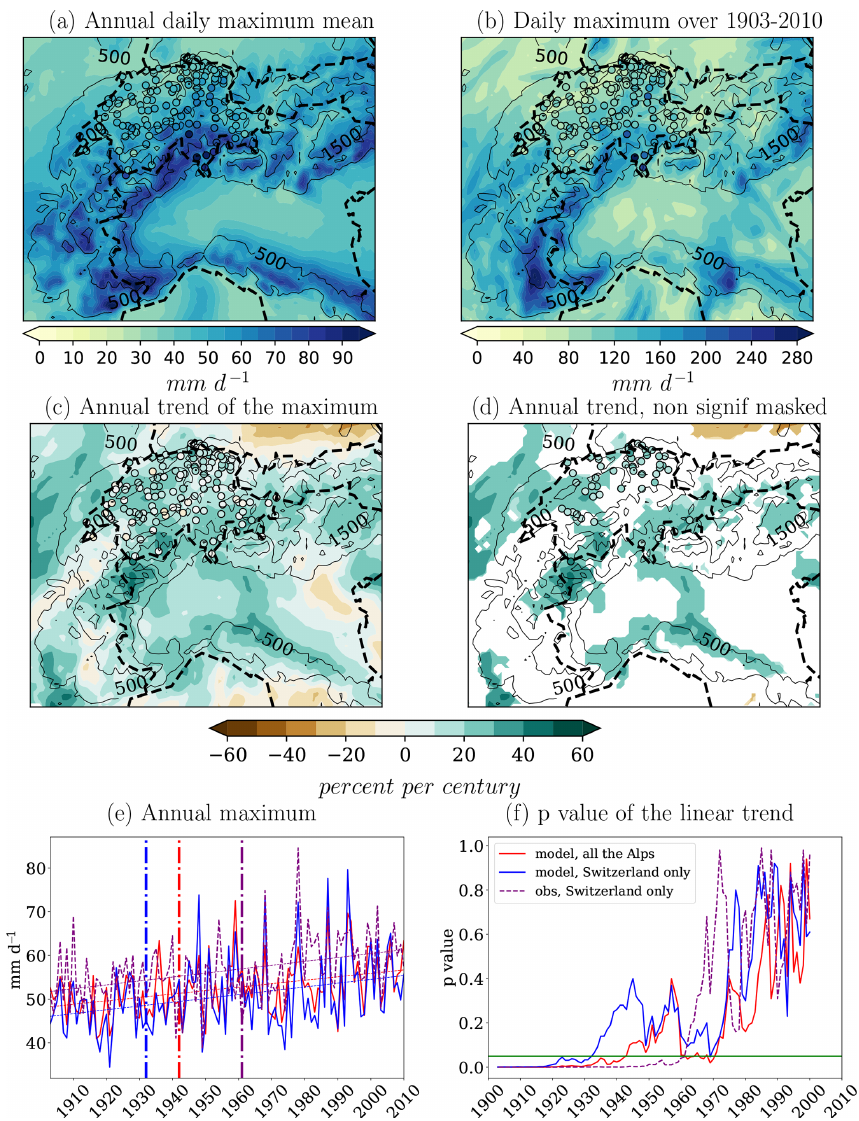
Figure 8. Mean (a) and maximum (b) of the annual Rx1day (mmd − 1 ) and its trend (% per century) including (c) and excluding (d) the areas where the p value is lower than 0.05, over 1903–2010. Annual Rx1day (e) and associated p value of the trend (f) over the same period averaged over the model domain (red for the entire Alpine region and blue for the Swiss domain only) and for the MeteoSwiss network (purple, average of the MeteoSwiss data station available over 1903–2010). The vertical bars in (e) highlight the year before which the p value never exceeds